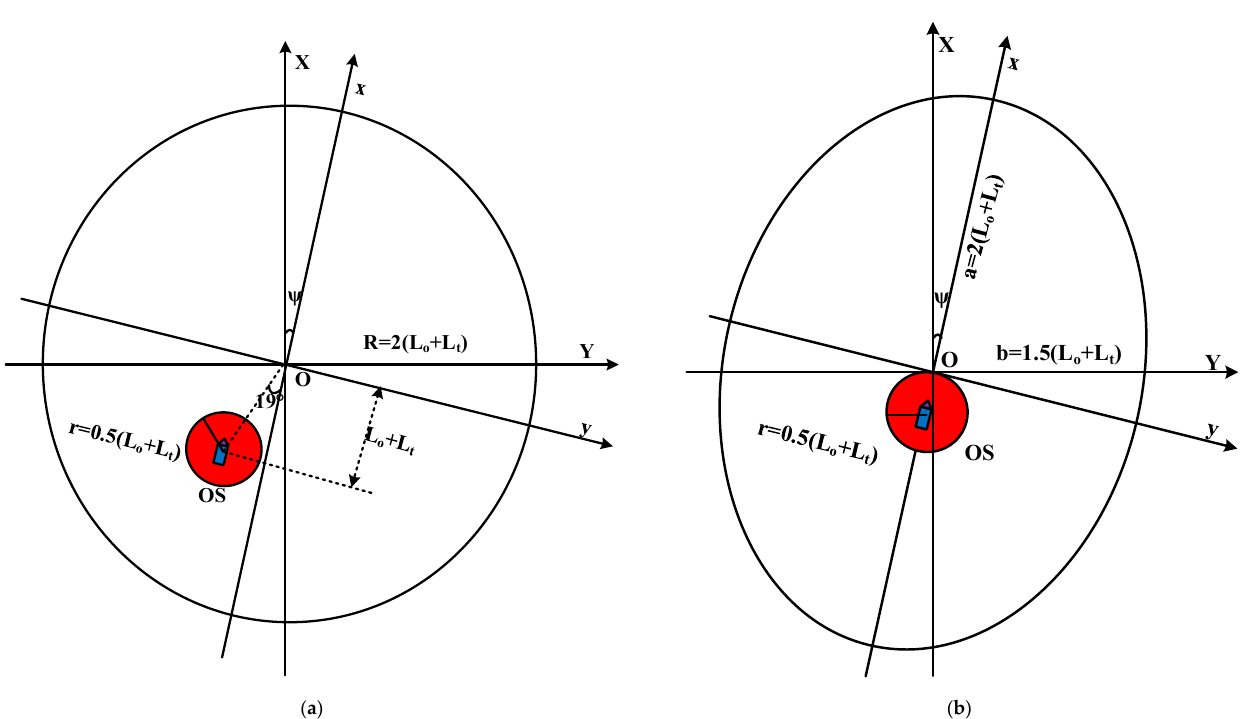
Figure 4. Range of ship domain and collision domain in the crossing/overtaking situation. ( a ) represents the domain in a crossing situation, and ( b ) represents the domain in an overtaking situation. The red circular area represents the collision domain with half the total lengths of two vessels. The ship domain in the crossing and overtaking situation. ψ represents the true course of the OS. The ship domain is represented by a circle and an ellipse in the crossing and overtaking